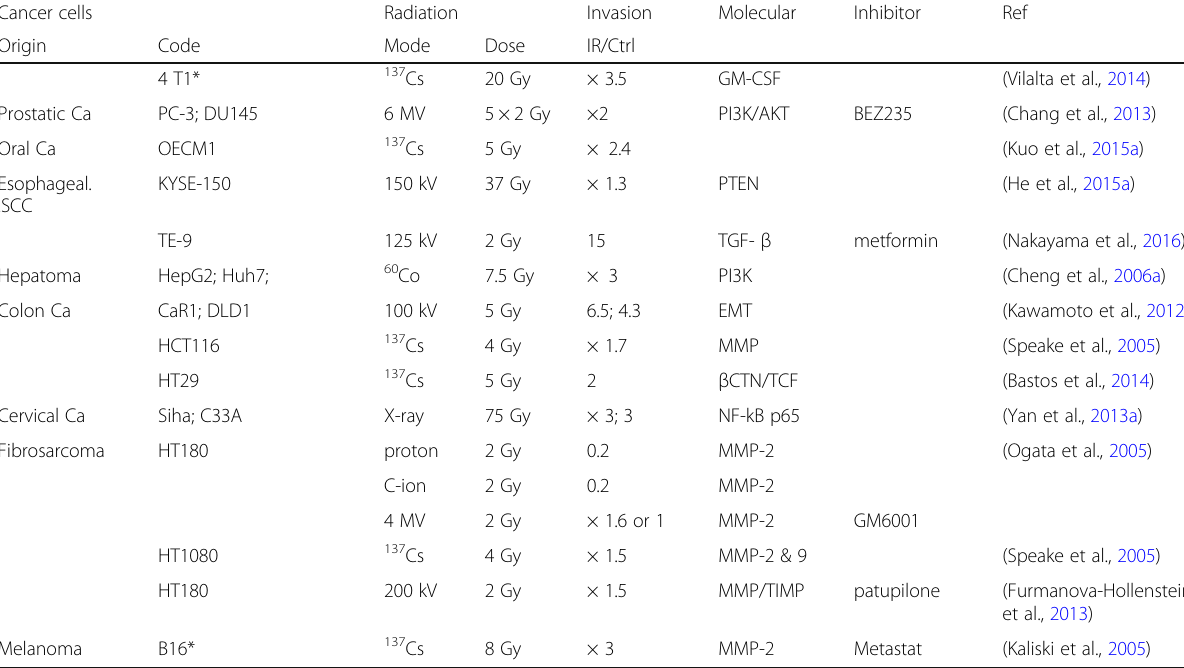
Most cell lines are human, except cell lines marked by an asterisks which are rodent. Inhibitors comprise agents that were used clinically, namely: BEZ235, an imidazoquinolone derivative and an inhibitor of PI3K and mTOR; CGS27023A, a matrix metalloproteinase inhibitor and anti-metastatic agent; Gefitinib, tyrosine kinase inhibitor targeting EGFR; GM6001, a broad -spectrum matrix metalloproteinase inhibitor known as galardin; Histamine, a biogenic amine that targets four (H1 – H4) histamine subtypes G-protein coupled receptors (GPCR); Metastat, a chemically modified tetracycline and inhibitor of gelatinase and MMP; Metformin, an anti-diabetic; MG132, a specific proteasome inhibitor; NK4, a four-kringle antagonist of hepatocyte growth factor and an angiogenesis inhibitor; Patupilone, a microtubule stabilizing drug; PHA665752, an ATP-competitive small-molecule inhibitor of the tyrosine kinase c-Met; PPA, Podophyllotoxin acetate, a microtubule inhibitor and a spindle poison; temozolomide, an alkylating chemotherapeutic drug; Thymoquinone, a regulator of NF- kB and extracellular signal-regulated kinase (ERK) signaling pathways. Abbreviations: Akt, protein kinase B; ANLN, human homologue of anailin; b1, beta1 integrin subunit, b-CTN, beta-catenin; BcL-2, B-cell lymphoma 2; BclxL, B-cell lymphoma-extra large; C-ion, carbon-ions; Ca, carcinoma; Co, cobalt; Cs, cesium; Ctrl, unirradiated control; CXCR4, C-X-C chemokine receptor type 4; EGFR, epidermal growth factor receptor; EMT, epithelial-to-mesenchymal transition; FAK, focal adhesion kinase; GCSF, granulocyte colony stimulating factor; Gy, gray; HGF, hepatocyte growth factor; IGF1, insulin-like growth factor-1; Met, tyrosine-protein kinase Met; MMP, matrix metalloproteinases; nm, not mentioned; NO, nitric oxide; Nrf2, Nuclear factor E2 related factor 2; PI3K, phosphatidylinositol 3-kinase; PPA, Podophyllotoxin acetate; Rho, Ras